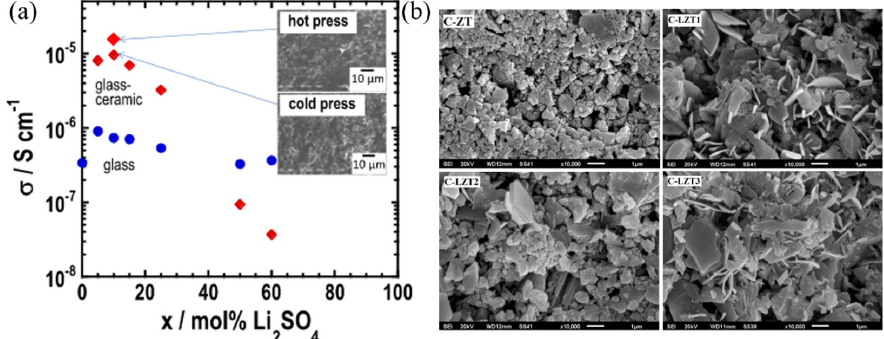
Figure 4. ( a ) Composition dependence of the ionic conductivity at room temperature of